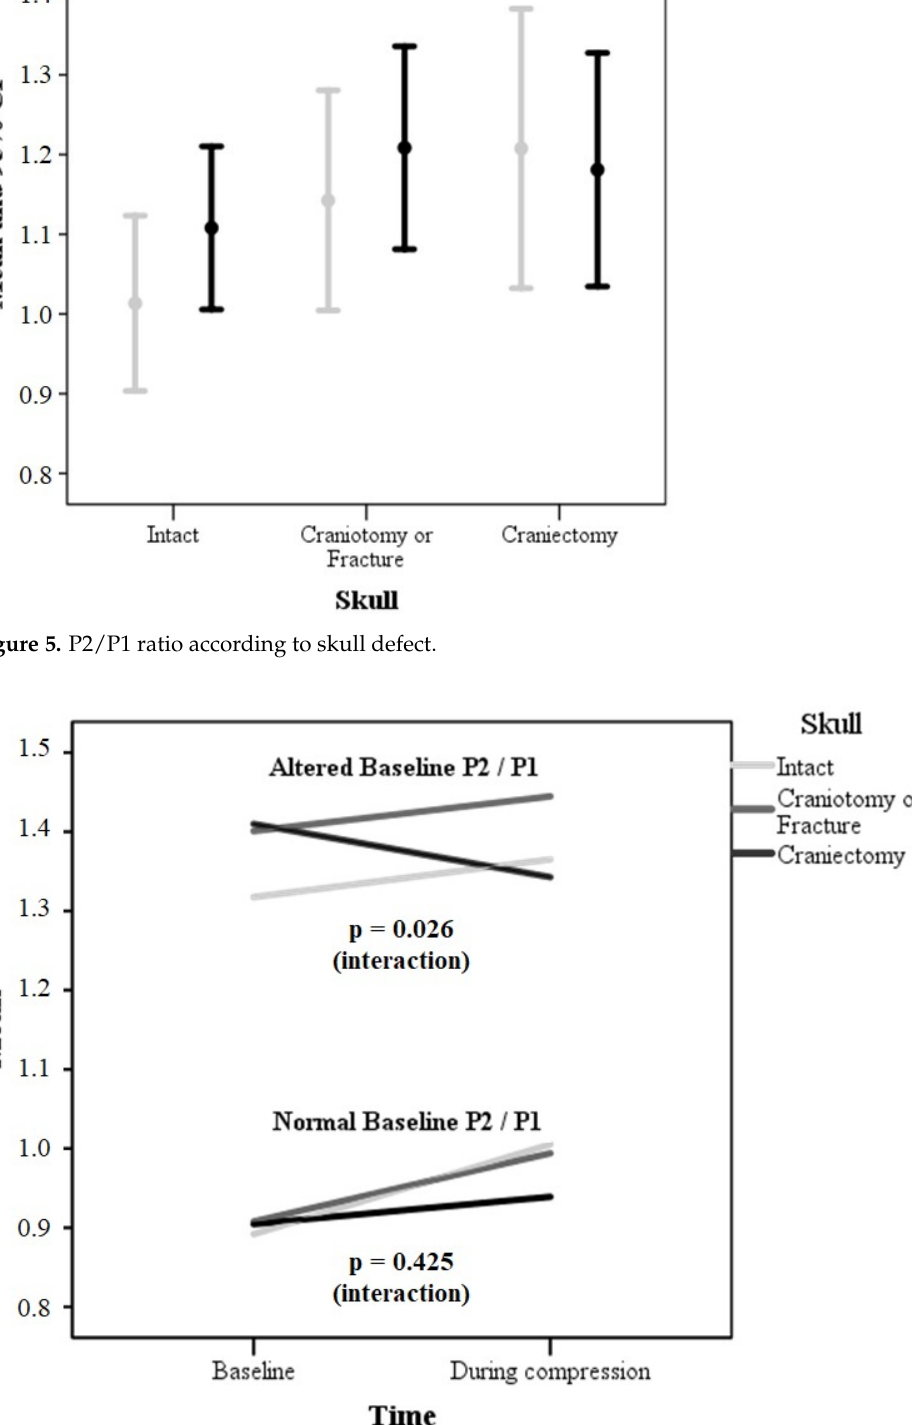
ciated with less P2/P1 ratio variation ( − 0.09, 95% IC − 0.15– − 0.02, p = 0.009), regardless of the baseline status. Table 3. Multivariable linear regression for P2/P1 variation (after compression—baseline). Variable